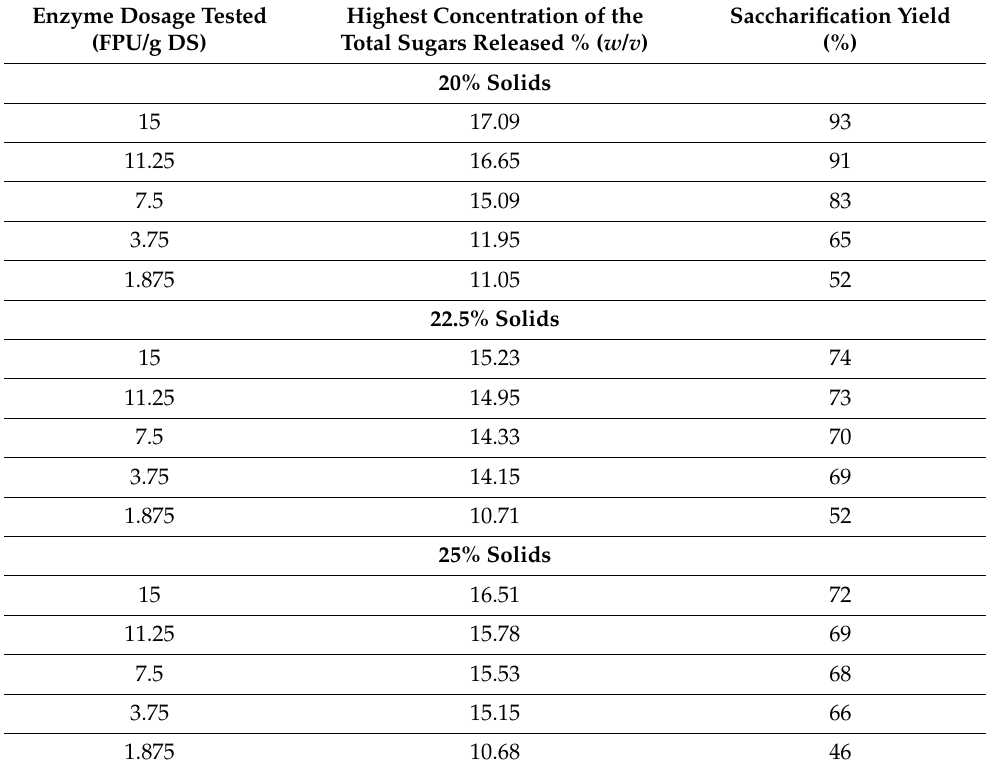
Table 2. Testing different enzyme dosages of Cellic CTEC 3 on deinked and deashed waste paper pulp during fed-batch addition of dry solids to reach 20%, 22.5% and 25% total solids concentrations.